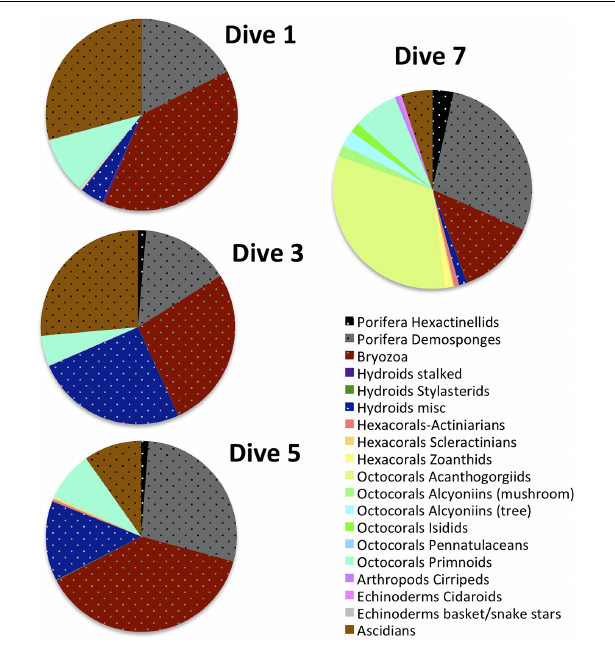
FIGURE 11 | Composition of VME indicator taxa at the 3 sites that trigger VME status via significantly higher abundances (Dives 1, 3, and 5) compared to the deepest site with a diverse assemblage of corals (Dive 7). VME indicator taxa that are more likely to occur at high densities and abundances that trigger typical management thresholds (sponges, hydroids, bryozoans and ascidians) are illustrated in stippled dark, bold colors while the highly diverse corals and other VME indicator taxa that typically do not are represented by paler